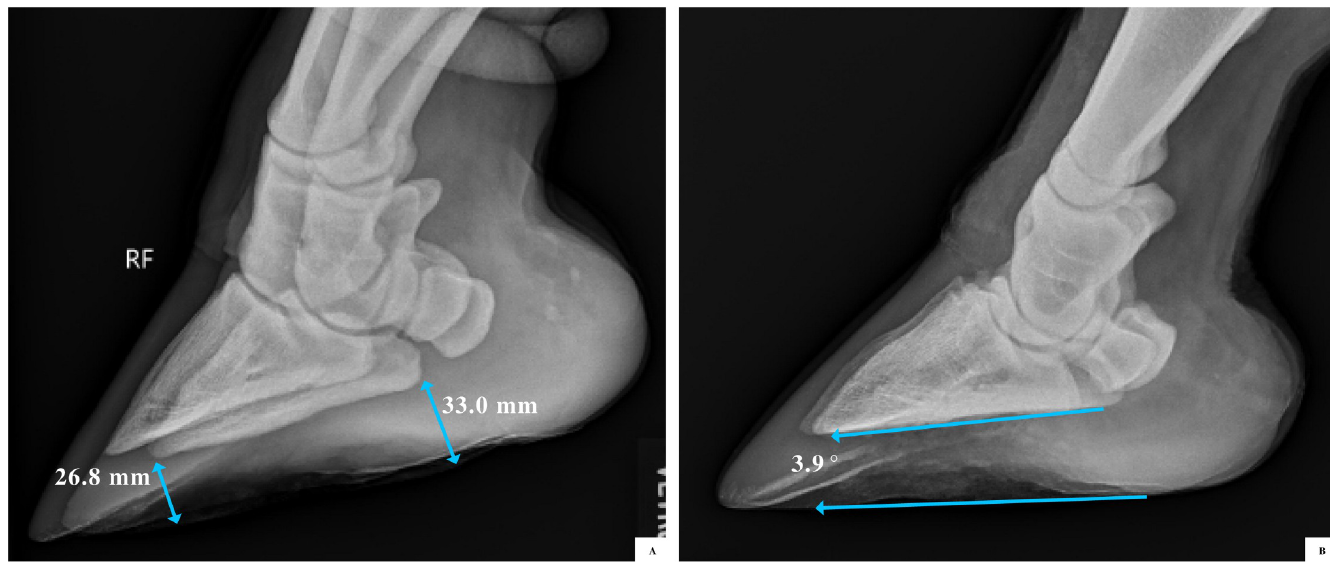
Fig 3. Giraffe foot sole height was thicker by the heel than by the toe tip, demonstrating a positive palmar angle. (A) Using an oblique view, sole thickness was measured from the most caudal and most distal weight-bearing aspect of P3. (B) For feet where medio-lateral or latero-medial radiographs were also available, the average palmar angle was 2.65˚ (range 1.88˚-4.29˚) and the average plantar angle was 2.26˚ (range 1.61˚-3.23˚).